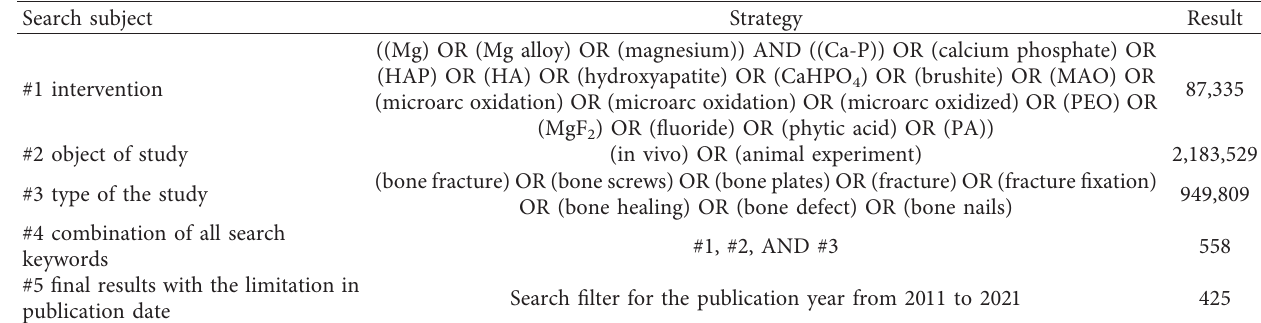
Table 2: Searching strategy and result: take Web of Science as example.